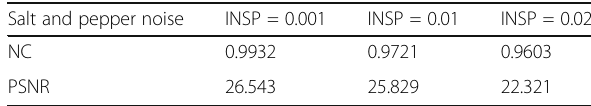
Table 2 Adding the salt and pepper noise attack with